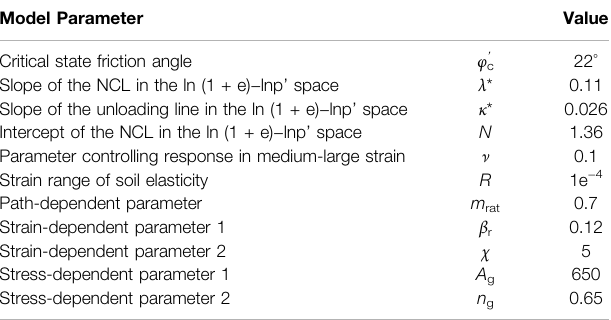
TABLE4| Summaryofthemodelparametersofthehypoplasticclaymodelforthe kaolin clay. Model Parameter